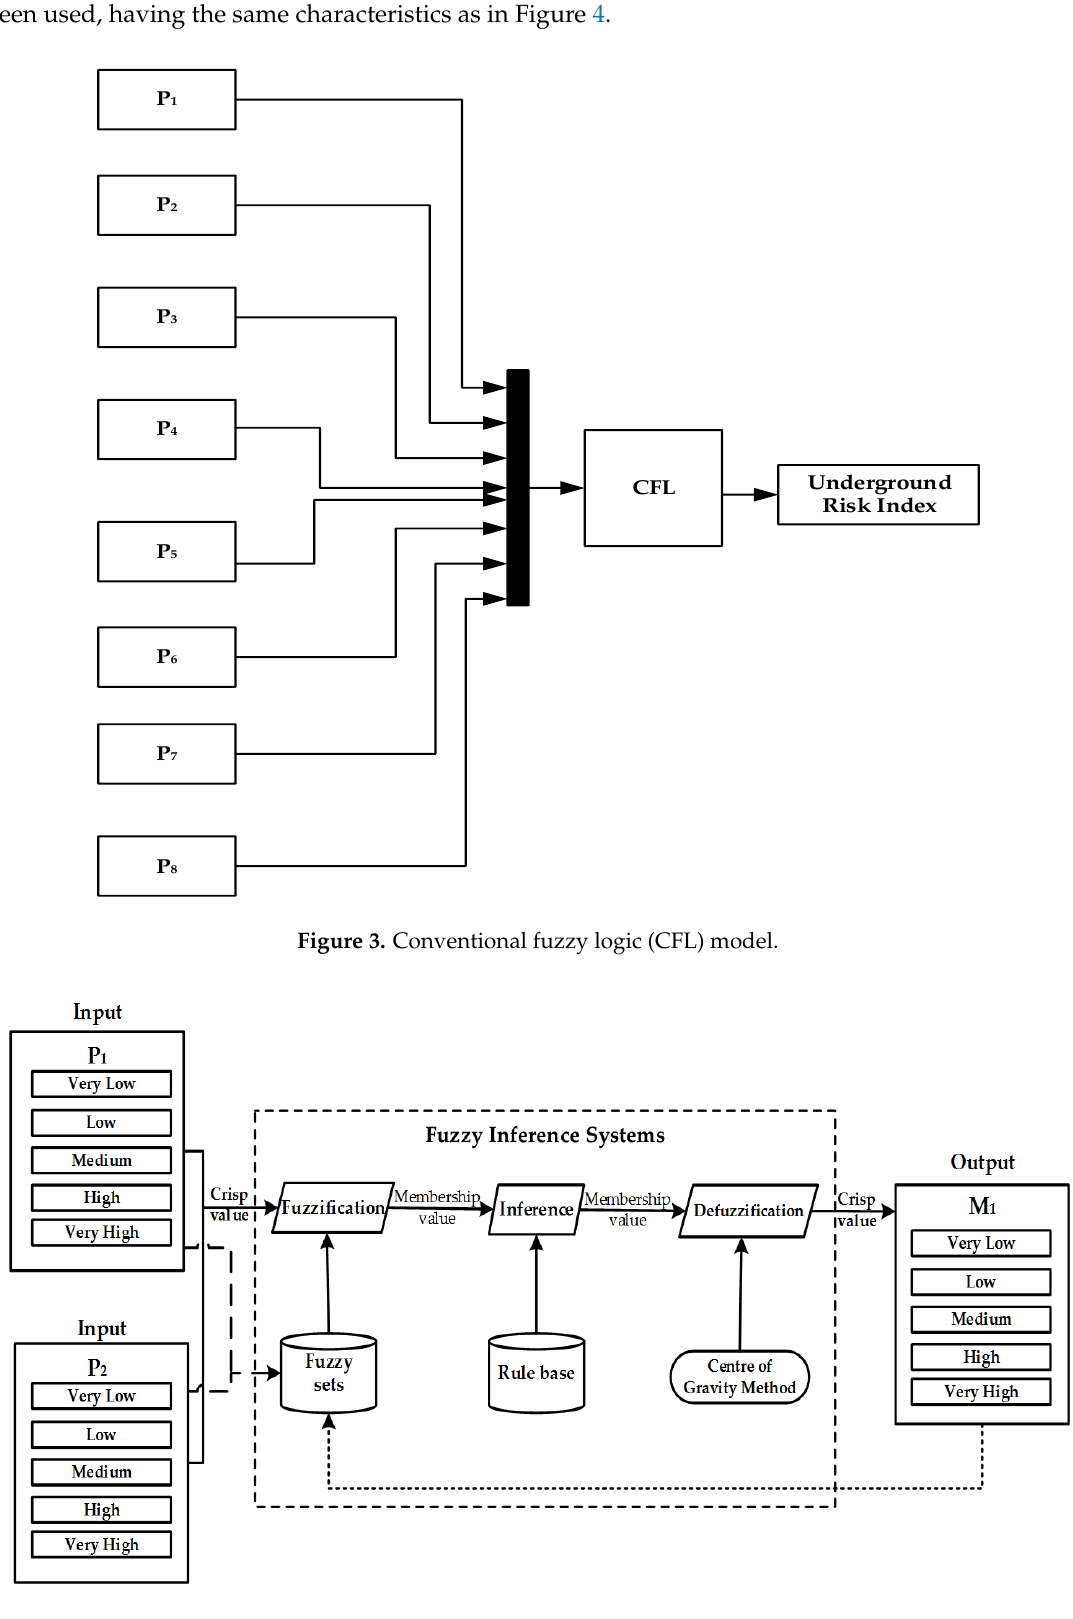
Figure 4. Structure diagram of Mamdani fuzzy logic model.